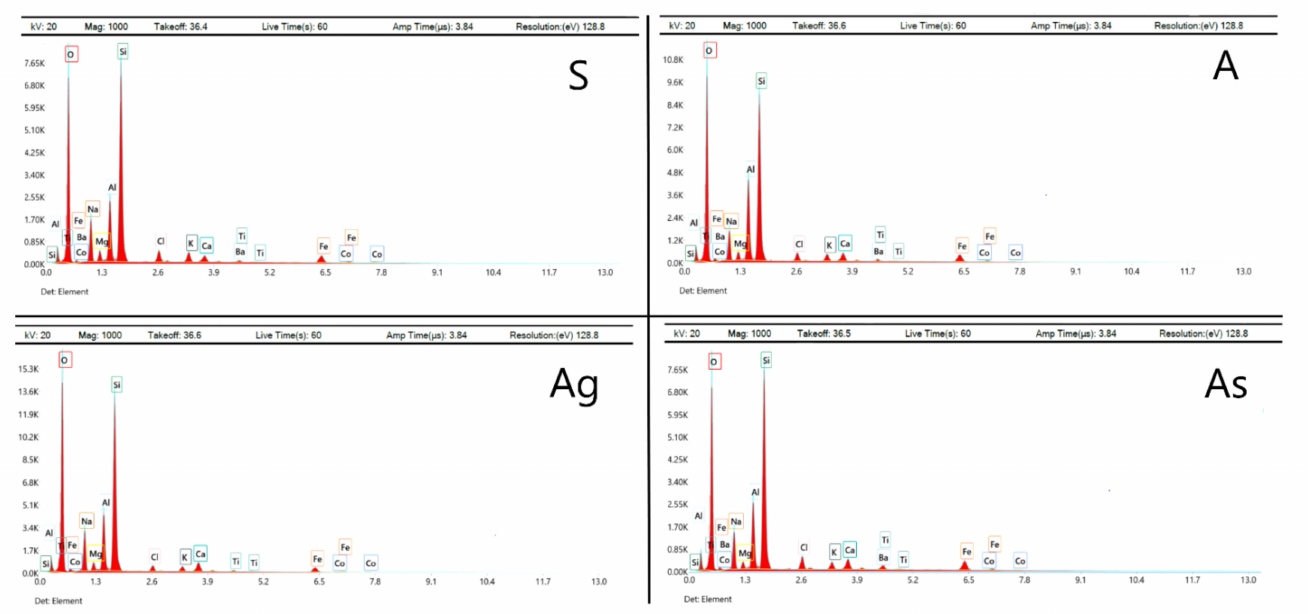
Figure 8. EDS spectra of synthesized